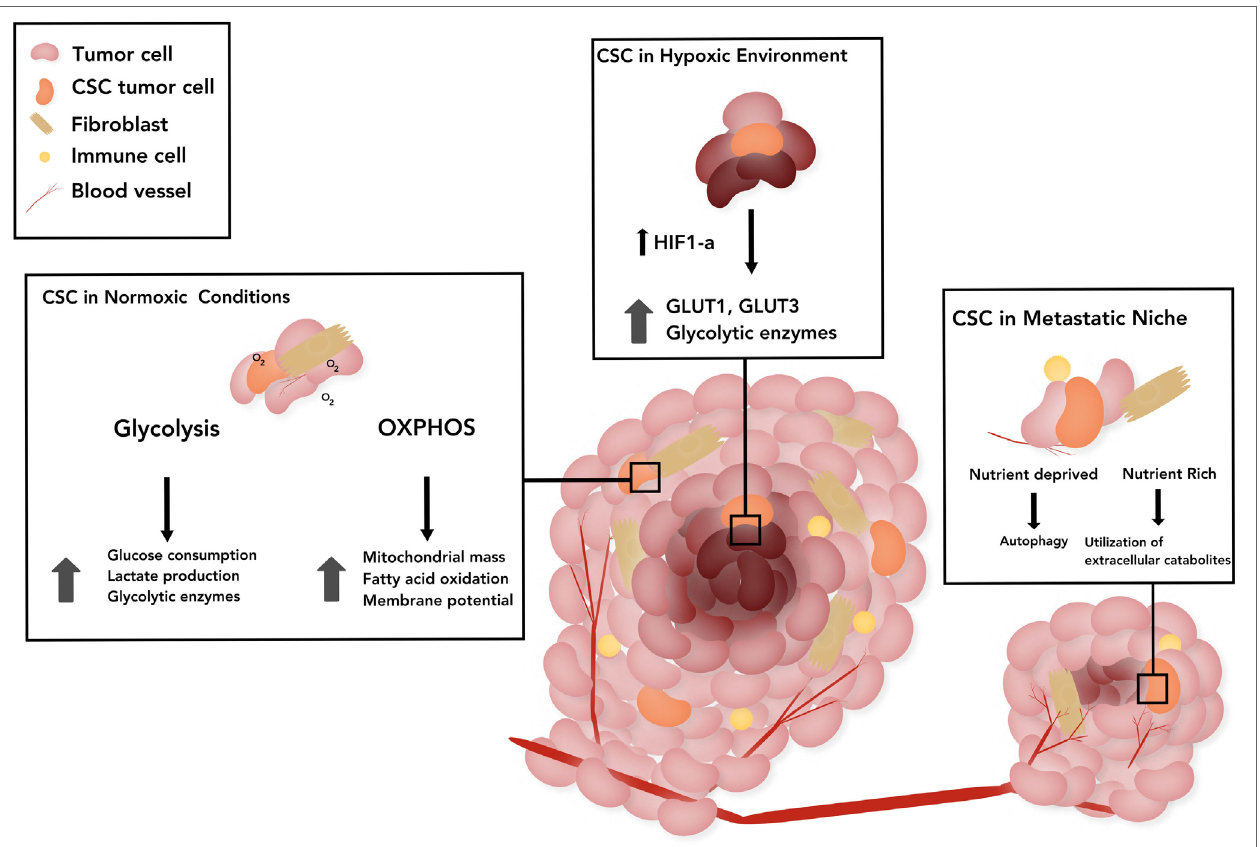
FiGURe 1 | The schematic represents the metabolic status of cancer stem cells (CSCs) in three broad categories based on the location. CSCs in a normoxic tumor: stemness has been associated with upregulation of glycolytic enzymes in those CSCs that rely on glucose pathway, as well as with dependence on mitochondrial pathway as evidenced by increased mitochondrial mass, membrane potential in CSCs and mitochondrial fatty acid oxidation (FAO) for generation of adenosine 5 ′ -triphosphate and nicotinamide adenine dinucleotide. CSCs in tumor under hypoxia: hypoxia-inducible factor-1 α (HIF-1 α ) promotes upregulation and potentiated activity of several glycolytic proteins, such as transporters (GLUT1, GLUT3) and various isoforms of glycolytic enzymes. CSCs in the metastatic niche: CSCs induced by epithelial-to-mesenchymal transition, have augmented utilization of extracellular catabolites, such as pyruvate, lactate, glutamine, glutamate, alanine, or ketone bodies. In nutrient poor states, quiescent disseminated tumor cells rely on alternative energy sources such as autophagy. The CSC stem cell model of treatment proposes the prevention of recurrence if all CSCs are